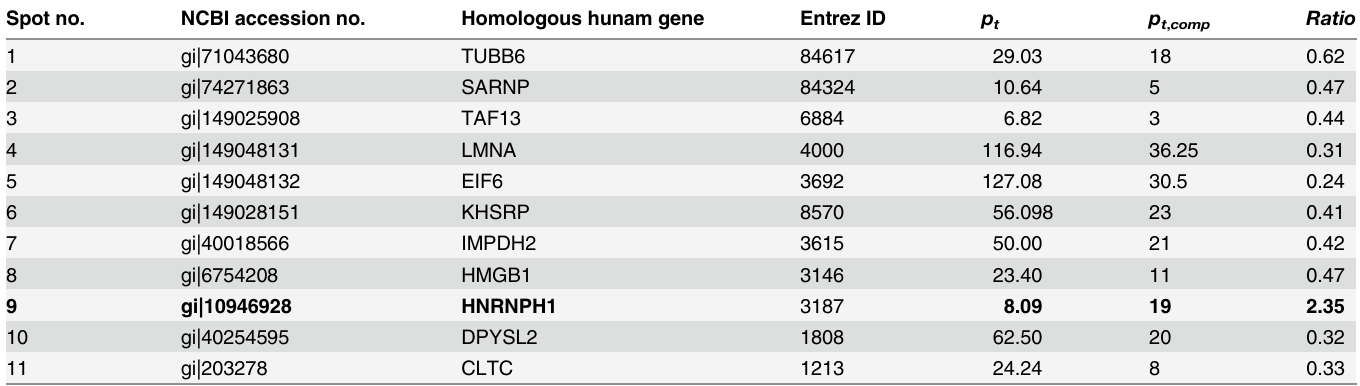
Table 1. The CYNA's targets obtained from comparative proteomic analysis, where p t and p t , comp represent a rough estimate of the amount of pulled-down protein before and after treatment by CYNA, respectively. Spot no. NCBI accession no.